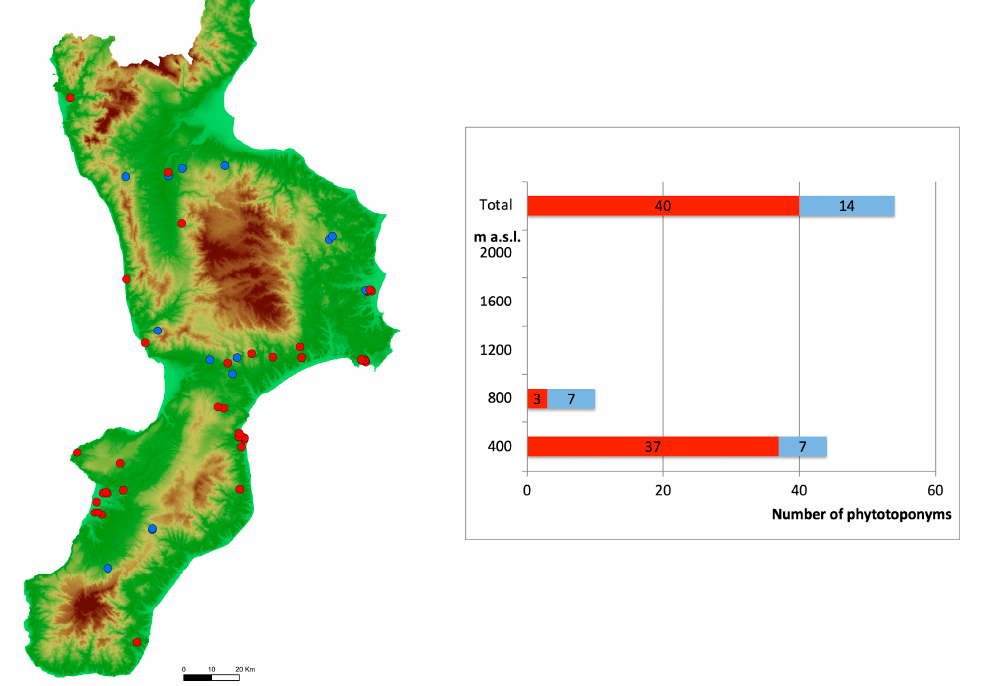
Figure 9. Distribution of phytotoponyms related to Quercus suber L. on map and by altitudinal belt. Blue, agreement with current forest vegetation; red, no agreement .